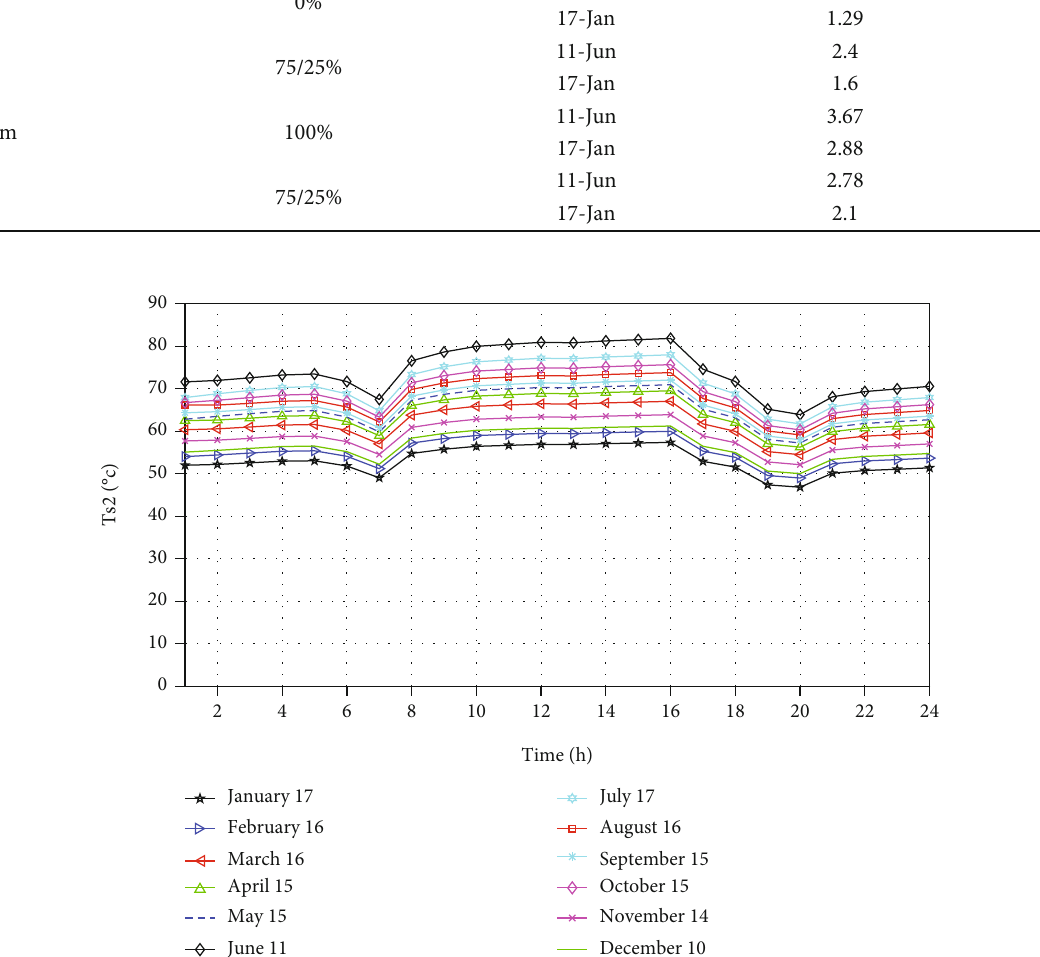
Figure 13: Water temperature in motel consumption with 1/3 of electrical energy storage in the battery for